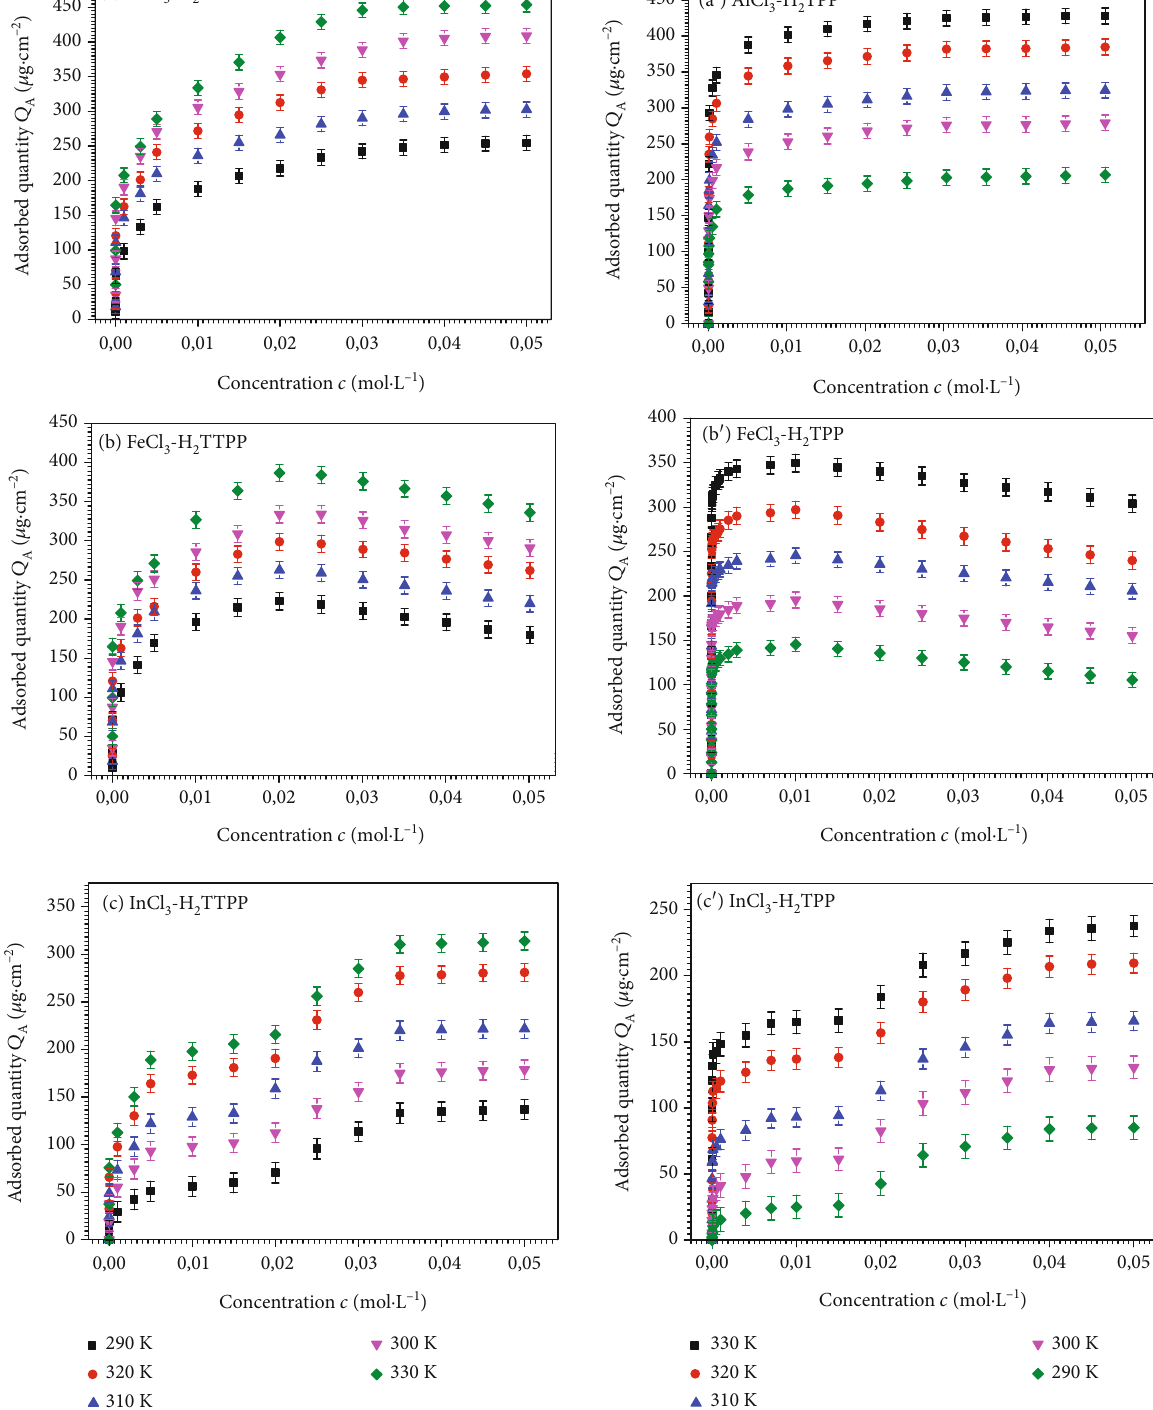
-H TTPP, system 3 2 -H 3 2